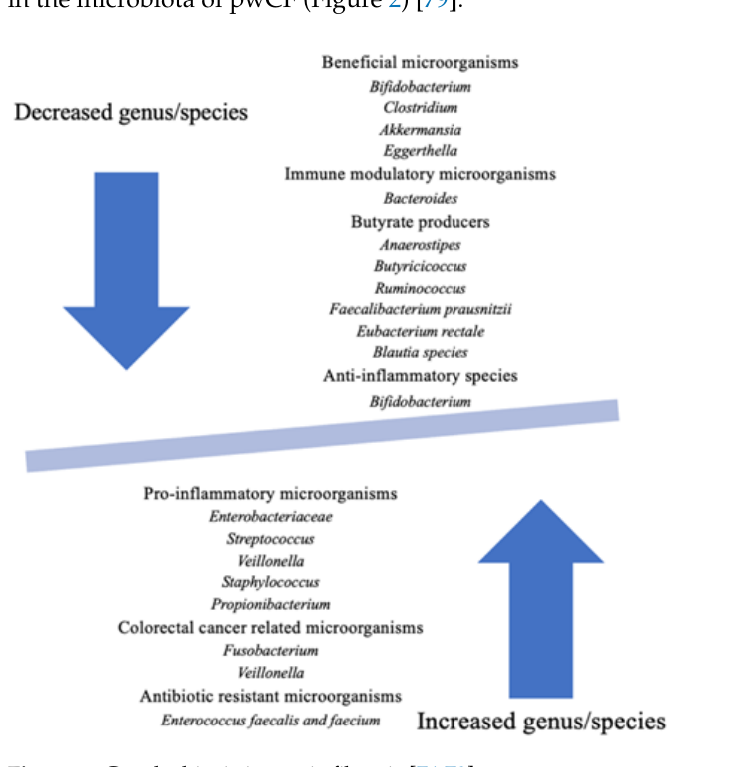
Figure 2. Gut dysbiosis in cystic fibrosis [74,79].